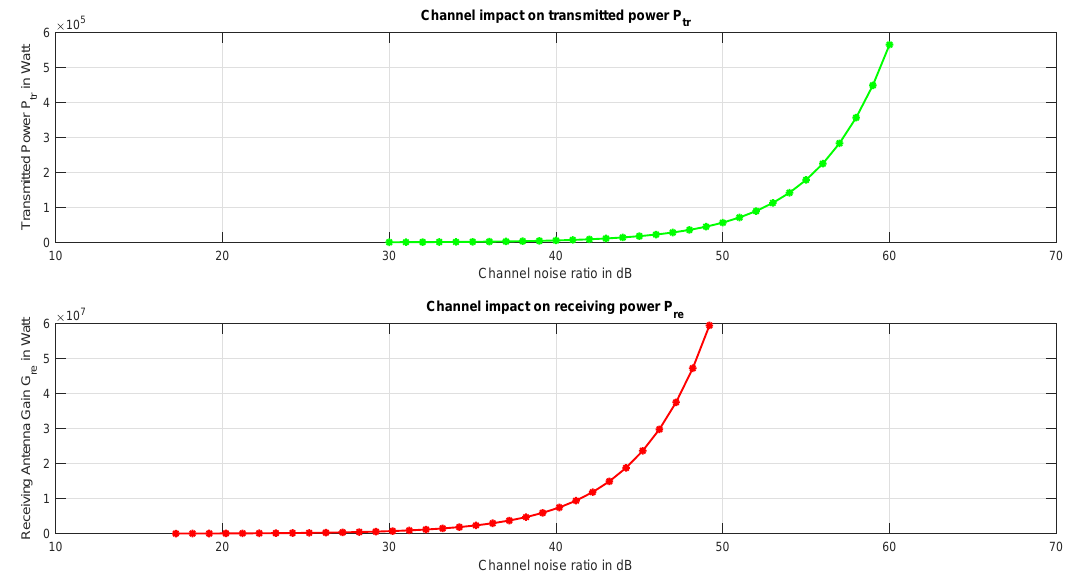
Figure 5. Link budget plot for wireless